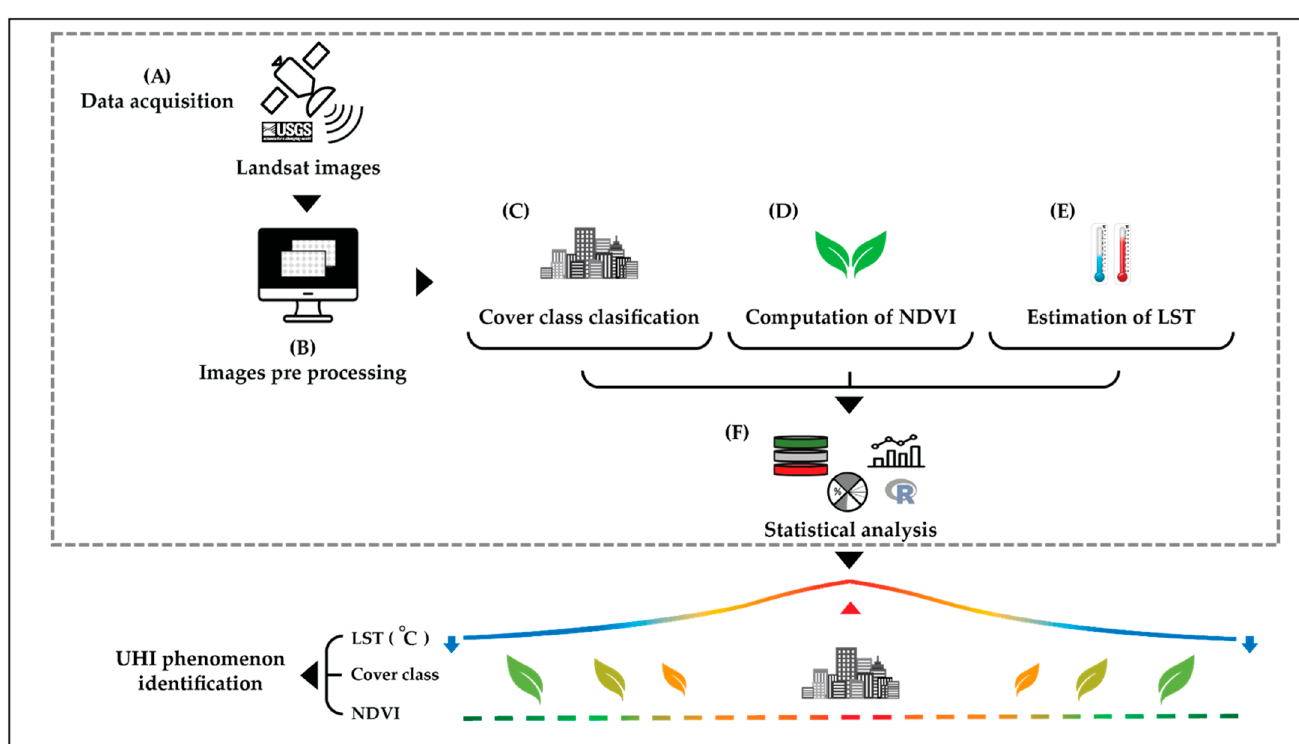
Figure 2. Graphic workflow of stages to identify urban heat island (UHI) phenomenon: ( A ) Data acquisition. ( B ) Imagery pre-procesing, ( C ) Land cover classification, ( D )calculation of NDVI, ( E ) estimation of and surfer temperature and ( F ) statistical analysis. Table 1. List of Landsat images used to carry out the analysis.